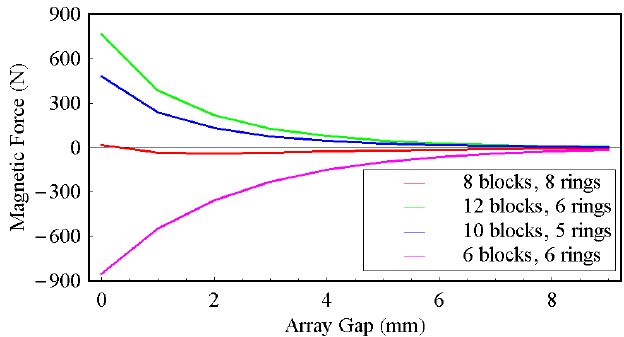
FIG. 4. (Color) Magnetic forces between the arrays for 10 periods of different PM ring undulator configurations. The legend gives the number of blocks making a single ring and the number of rings making a